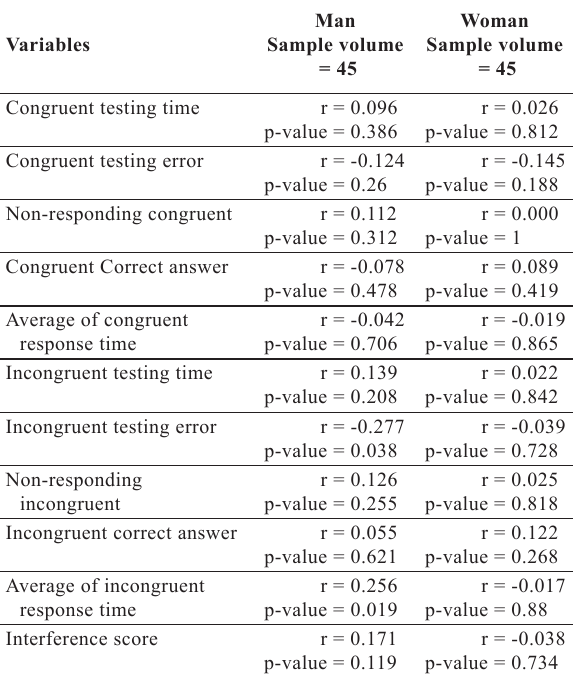
Table 4. Investigating the relationship and correlation values between genders by variables of SAT